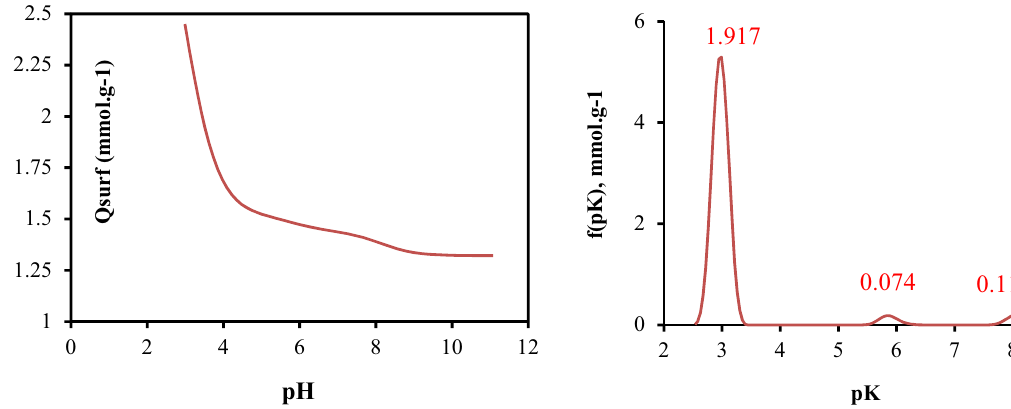
Figure 1. Potentiometric titration curve for PP.